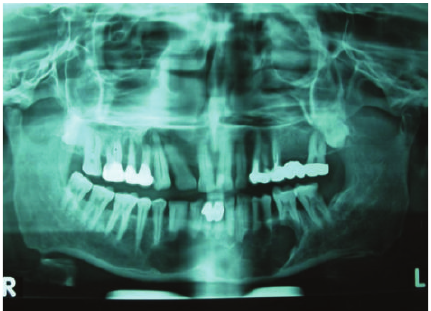
Figure 1: Swelling on lingual surface on the left side of the mandible extending from 33 to 36.